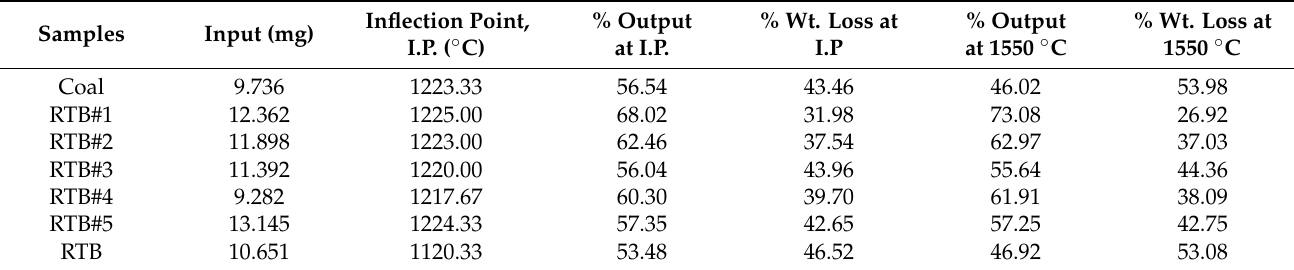
Figure 5. TGA analysis of raw carbon composite pellet (CCP) for all samples compared to that of coal. Table 6. TGA data of the carbon composite pellet (CCP) for all